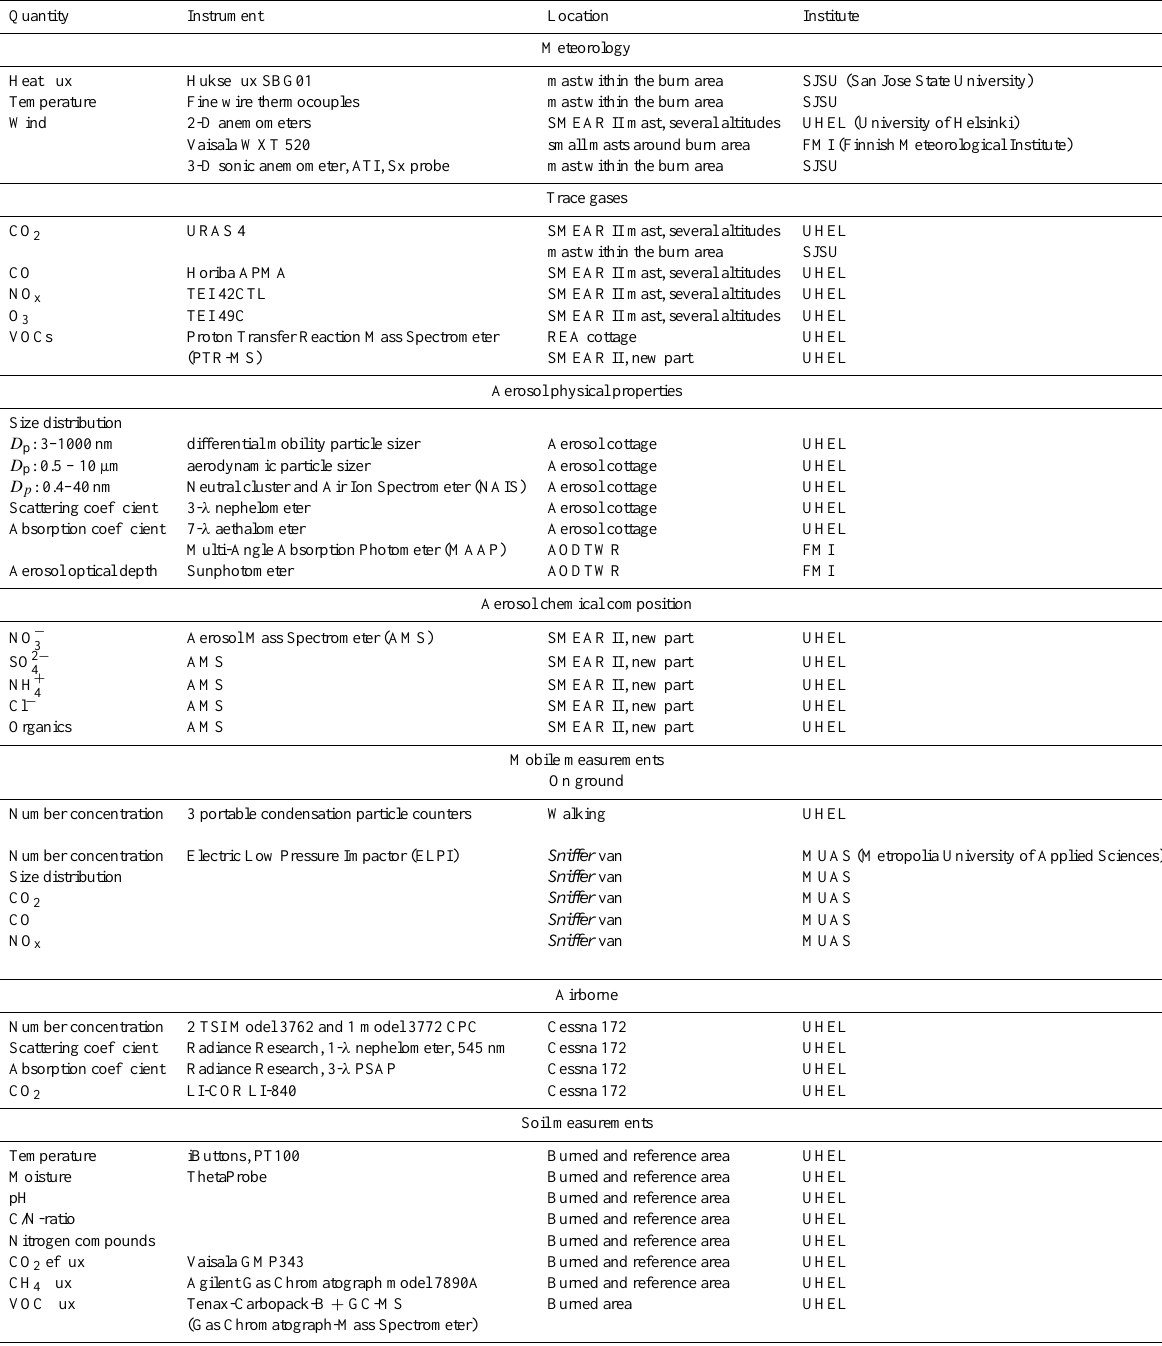
Table 2. Measurements made during the prescribed fire experiment, the instrument type, location of the instrument, and the responsible